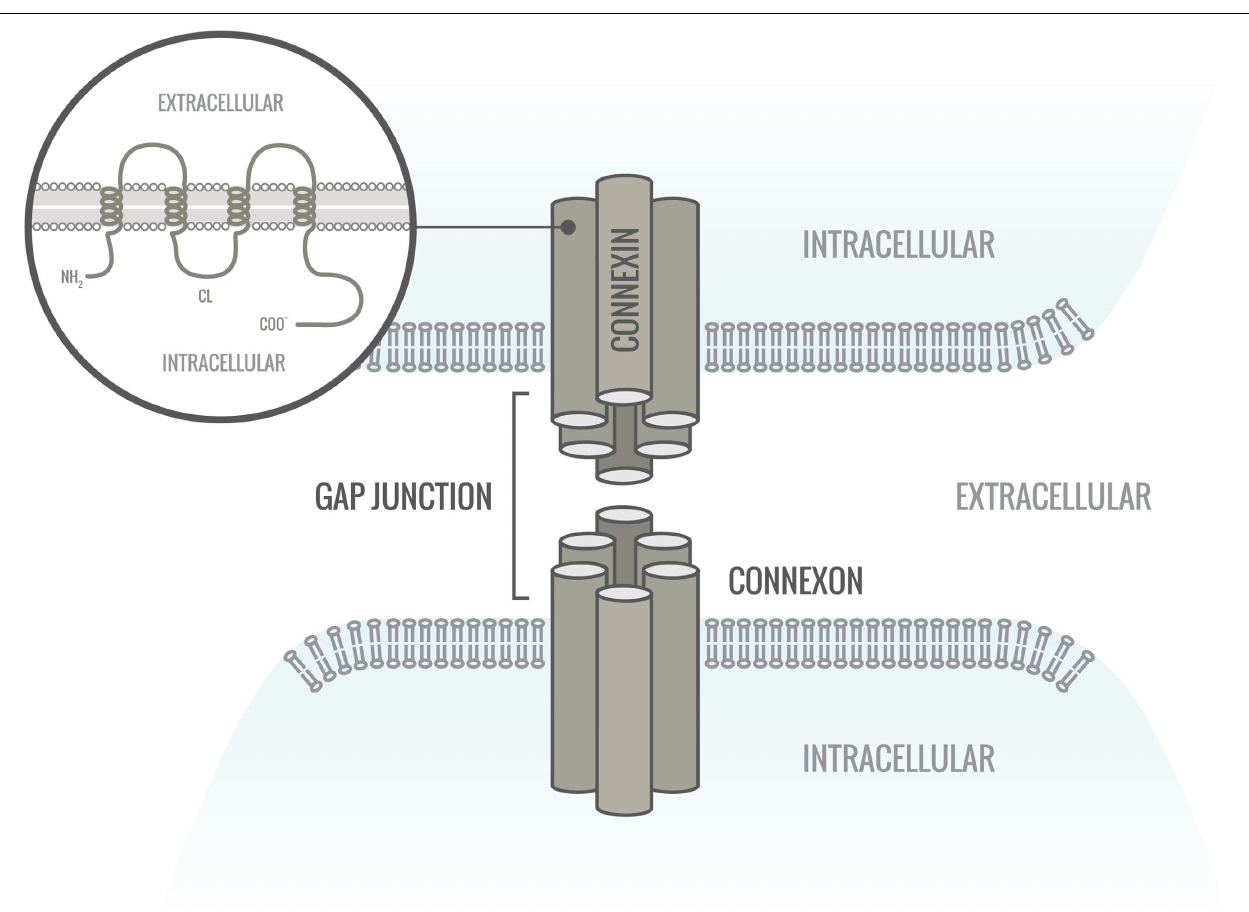
FIGURE 1 | The cardiac gap junction. Gap junctions are located in the intercalated disc. They consist of two hemichannels (connexons) connecting across the intercellular space. Each hemichannel is provided by one cell and connexons are composed of six hexagonally arranged connexin proteins.